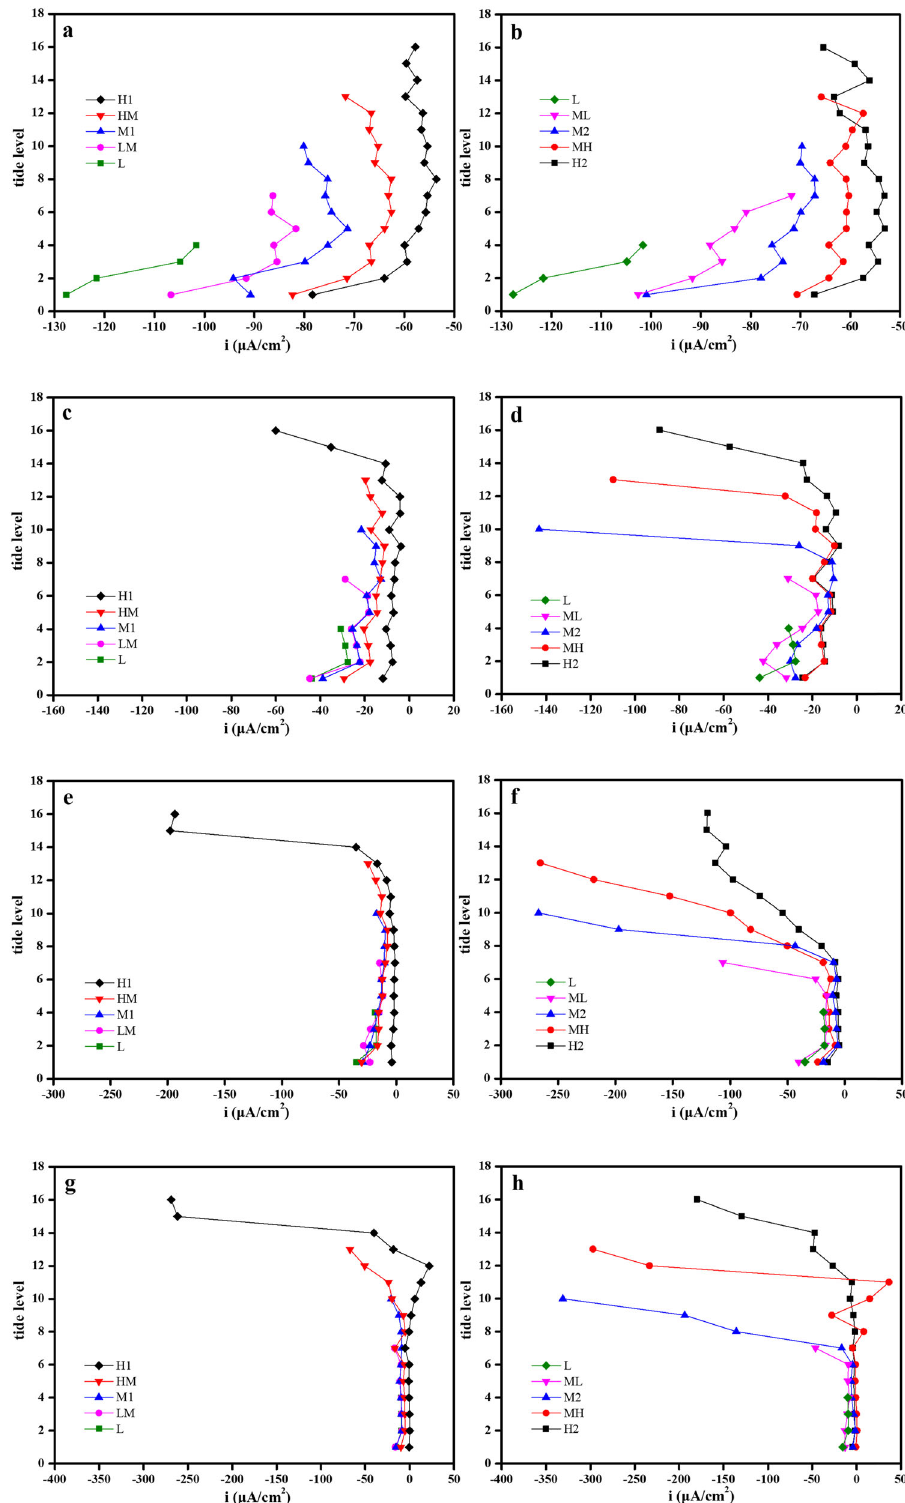
Fig. 3 Average current density distributions. Average current density distributions of a single row of fi ve electrodes at different tide levels on a , b 1st, c , d 15th, e , f 23rd, and g , h 40th day of on the 10th day. The semicircular arc in the high-frequency region and the semicircular arc with a diffusion tail in the low-frequency region were maintained until the end of the experiment. We used the same equivalent circuits as those employed in the case of 3-1#